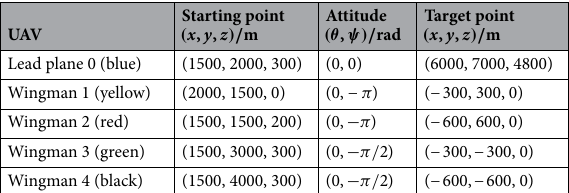
Table 2. Initial parameters of the no-obstacle simulation scene.